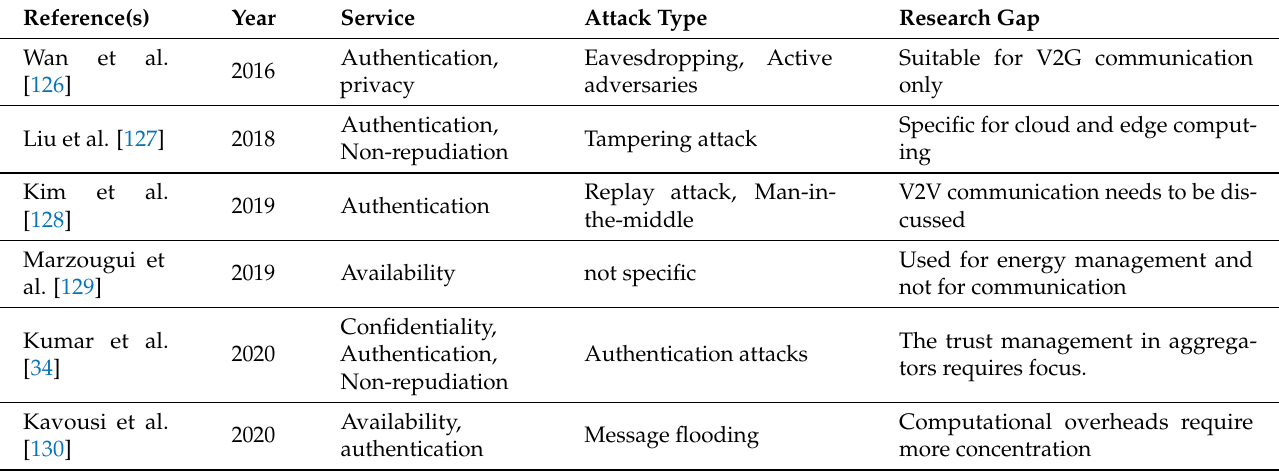
Table 9. List of security solutions for electric